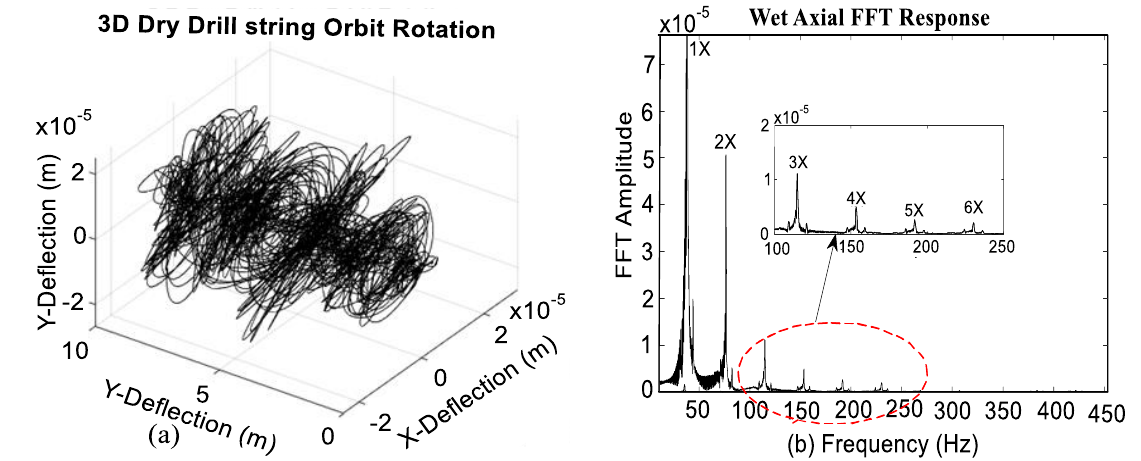
Figure 10. Response of the imbalanced drill string-casing system with rubbing. ( a ) 3D imbalanced drill string response orbit in air with rub; ( b ) FFT response of imbalanced and rubbed drill in air.